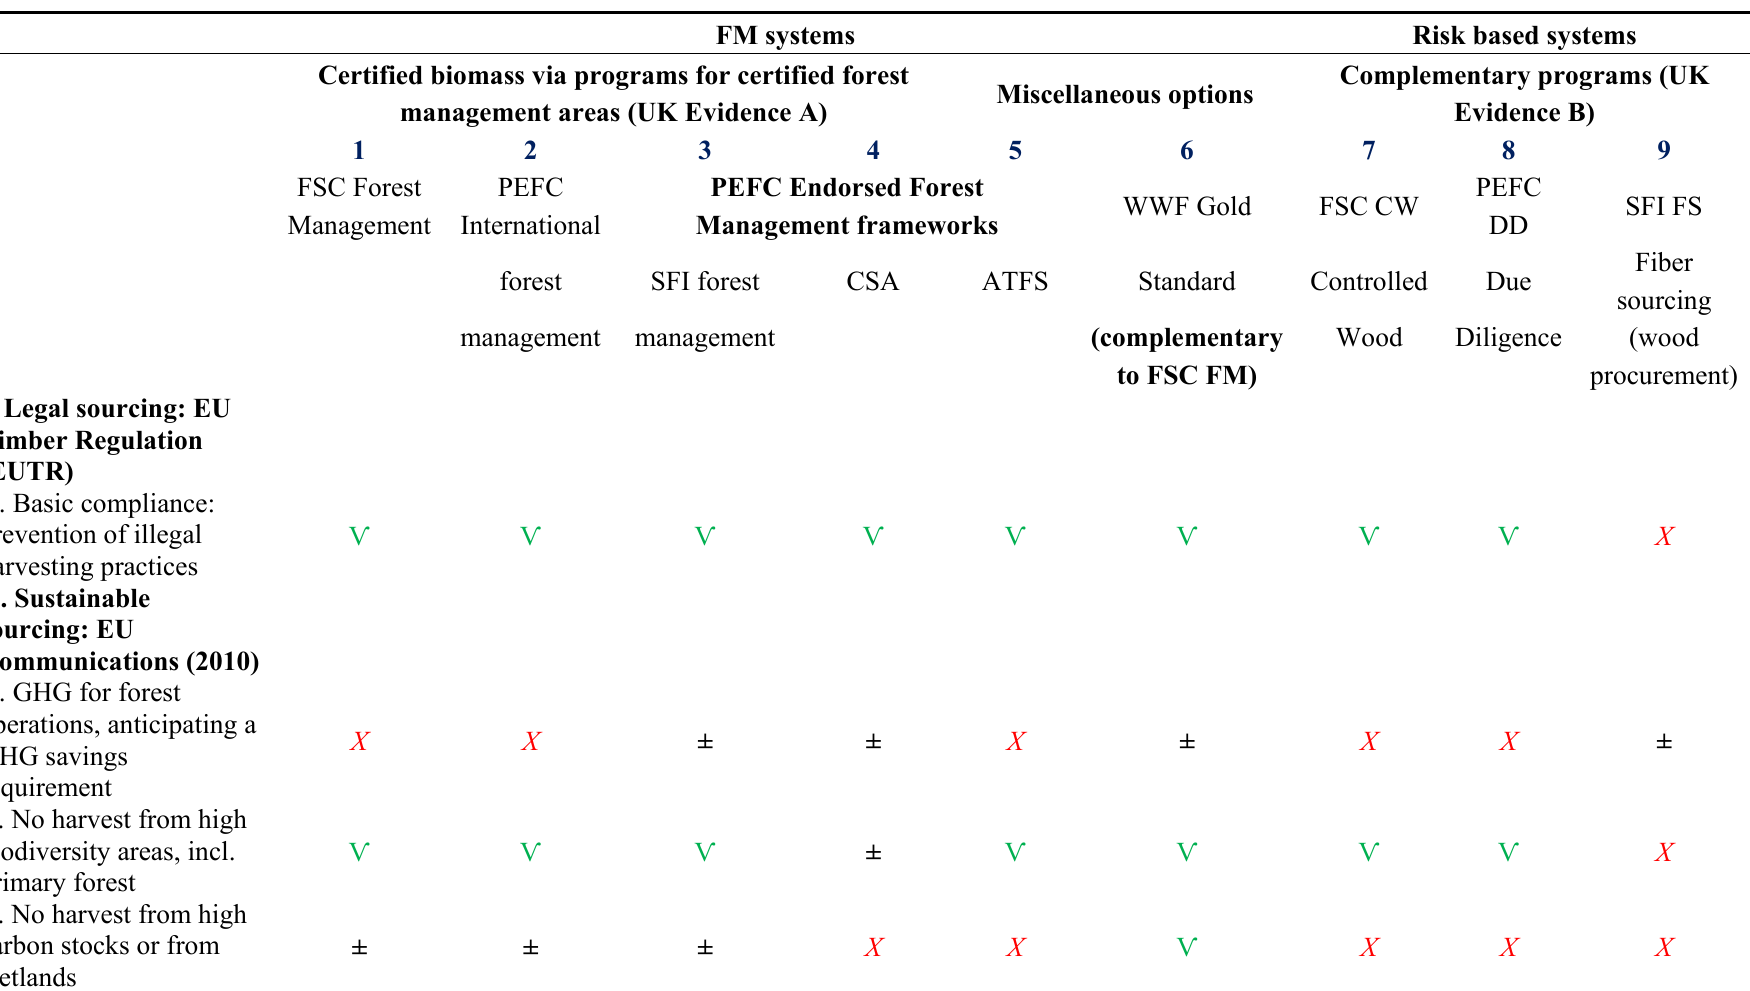
Table 3. Benchmark for legal harvesting [6], sustainable sourcing [9] and cascaded use [73] of woody biomass for energy in the EU: their coverage through sustainable forest management (SFM) programs in North